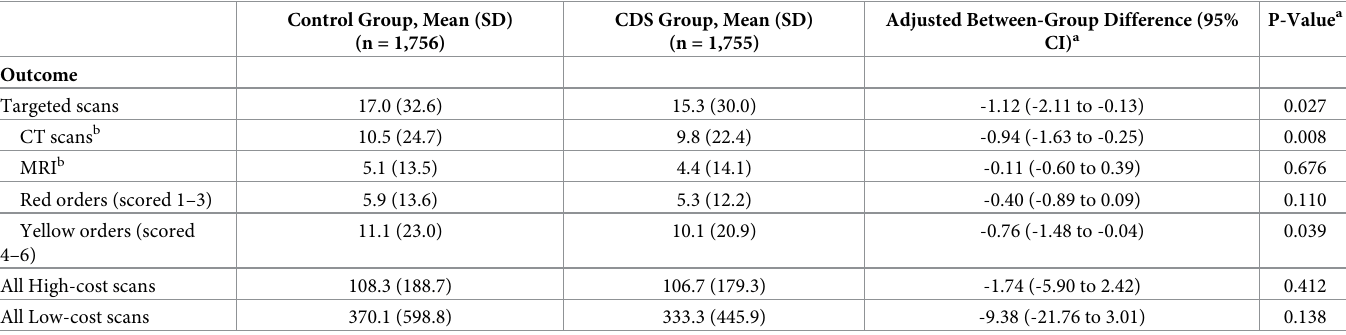
Table 2. Impact of CDS on